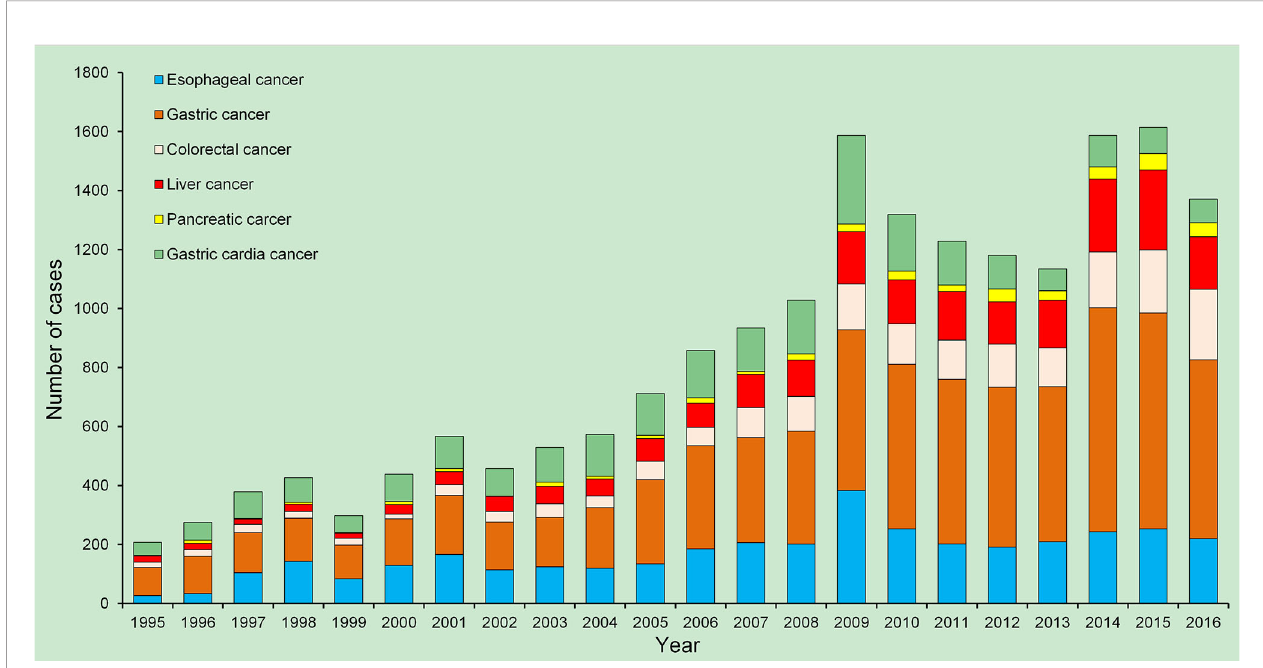
FIGURE 1 | Temporal trends in the numbers of the major gastrointestinal (GI) cancer cases in Wuwei, northwestern China, 1995 – 2016, China.